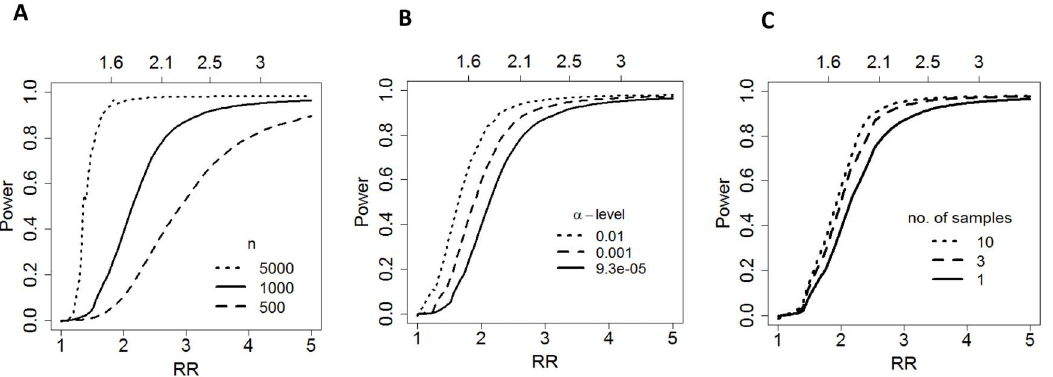
Figure 4. The curves show the proportion of metabolites expected to be detected in a case control study as a function of effect size. Effect size is defined by the relative risk (RR, on the x-axis) of disease comparing individuals in the top and bottom quartiles of the ‘‘usual’’ metabolite level. The top axis shows the naı¨ve relative risk that would be observed in the study without adjusting for measurement error. Each figure varies one parameter: sample size, a -level, or the number of samples/individual. (A) presents power curves according to different sample size (n of 500, 1,000 and 5,000) under a Bonferroni-adjusted a -levels (0.05/539); (B) presents power curves with different a -levels in a case-control study of 1,000 individuals; (C) presents power curves in a case-control study of 1,000 individuals, with different number of distinct urinary samples (1, 3, and 10, a - level=0.05/539).